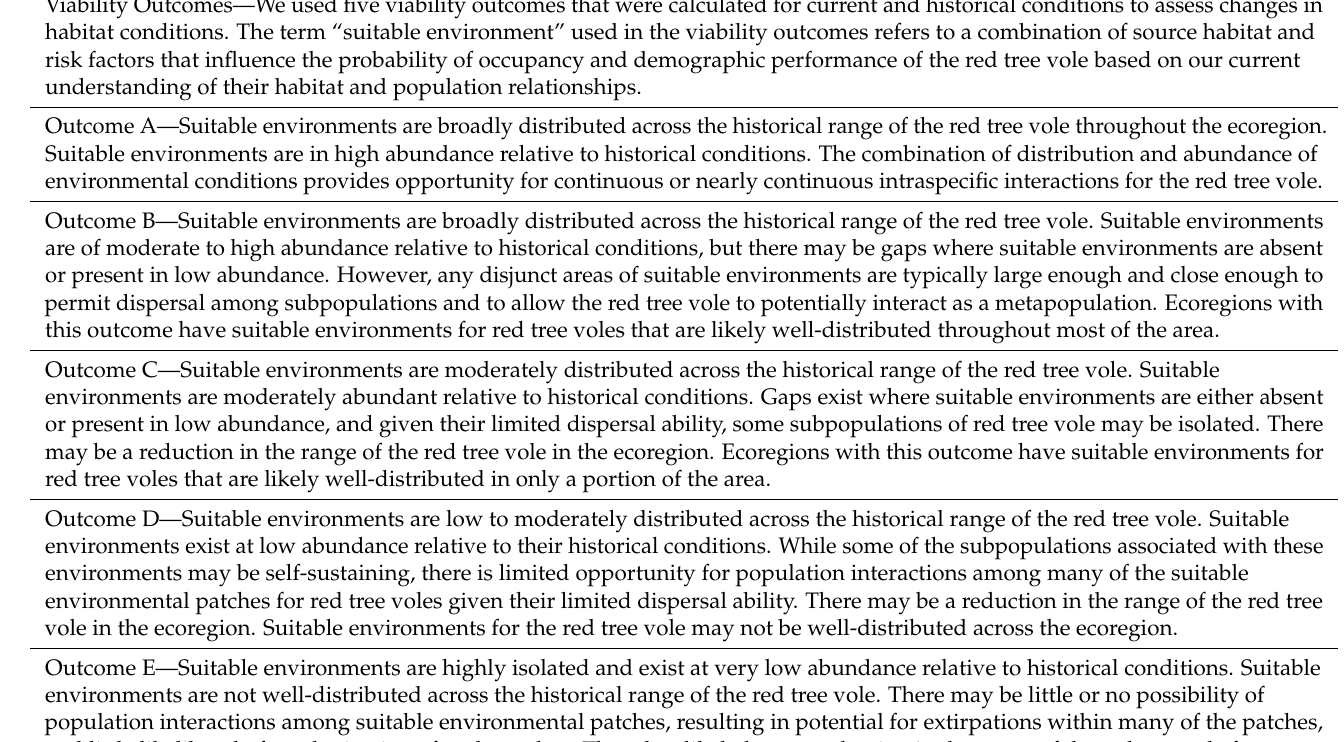
Table 4. Viability outcomes used to describe amount, quality, connectivity, and distribution of current and historical suitable environments that influenced the viability of the red tree vole ( Arborimus longicaudus ) in the evaluation area in Oregon and California, USA.